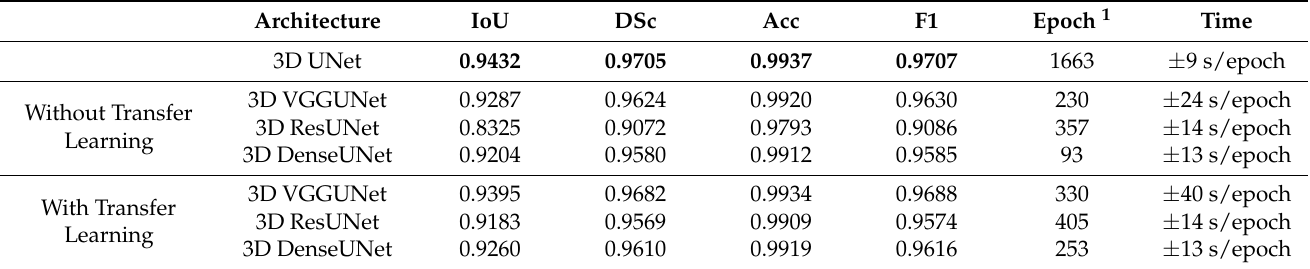
Table 5. The IoU Score, Dice Score, accuracy, F1-score epoch of learning, and time per epoch results of each architecture for the CT-scan binary-class